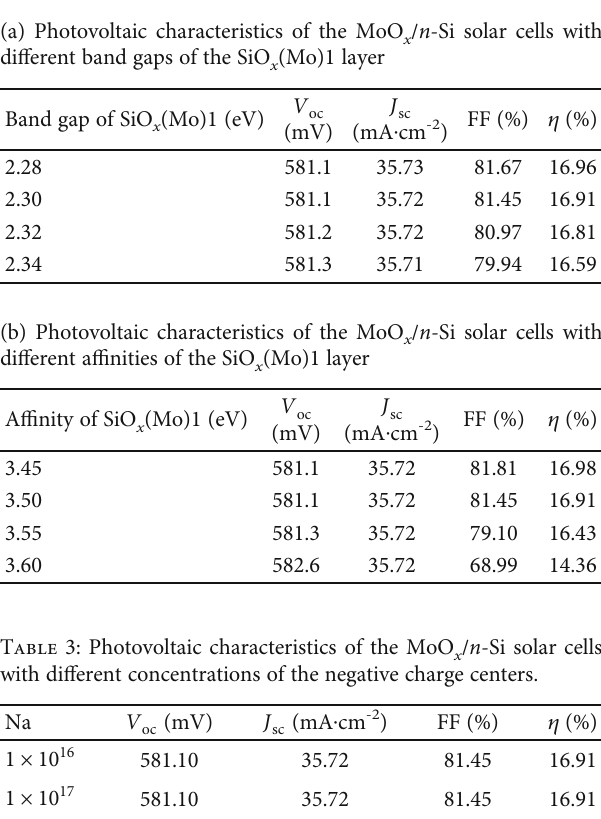
/ n -Si solar cells with x (Mo)1 layer x V oc (Mo)1 (eV) x (mV)